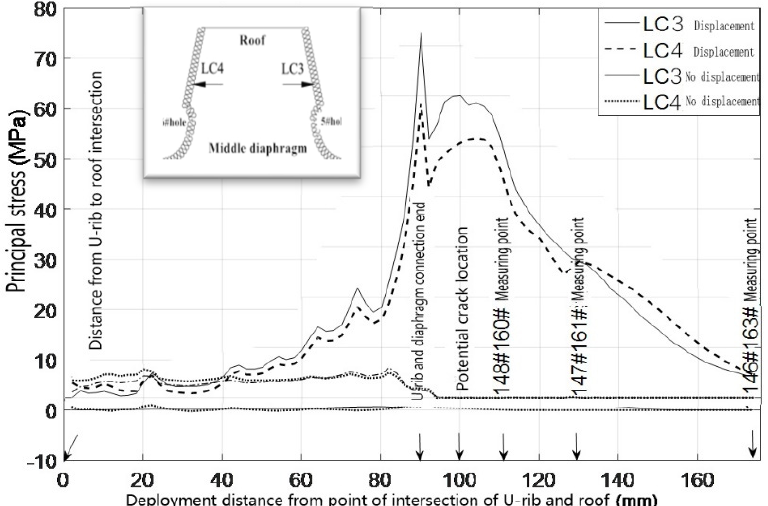
Figure 6. Principal stress distribution around the left side of the diaphragm 5# hole and the right side of the diaphragm 6# hole. Note: LC1: 4# hole left peripheral unit; LC2: 5# hole right peripheral unit; LC3: 5# hole left peripheral unit; LC4: 6# hole right peripheral unit.